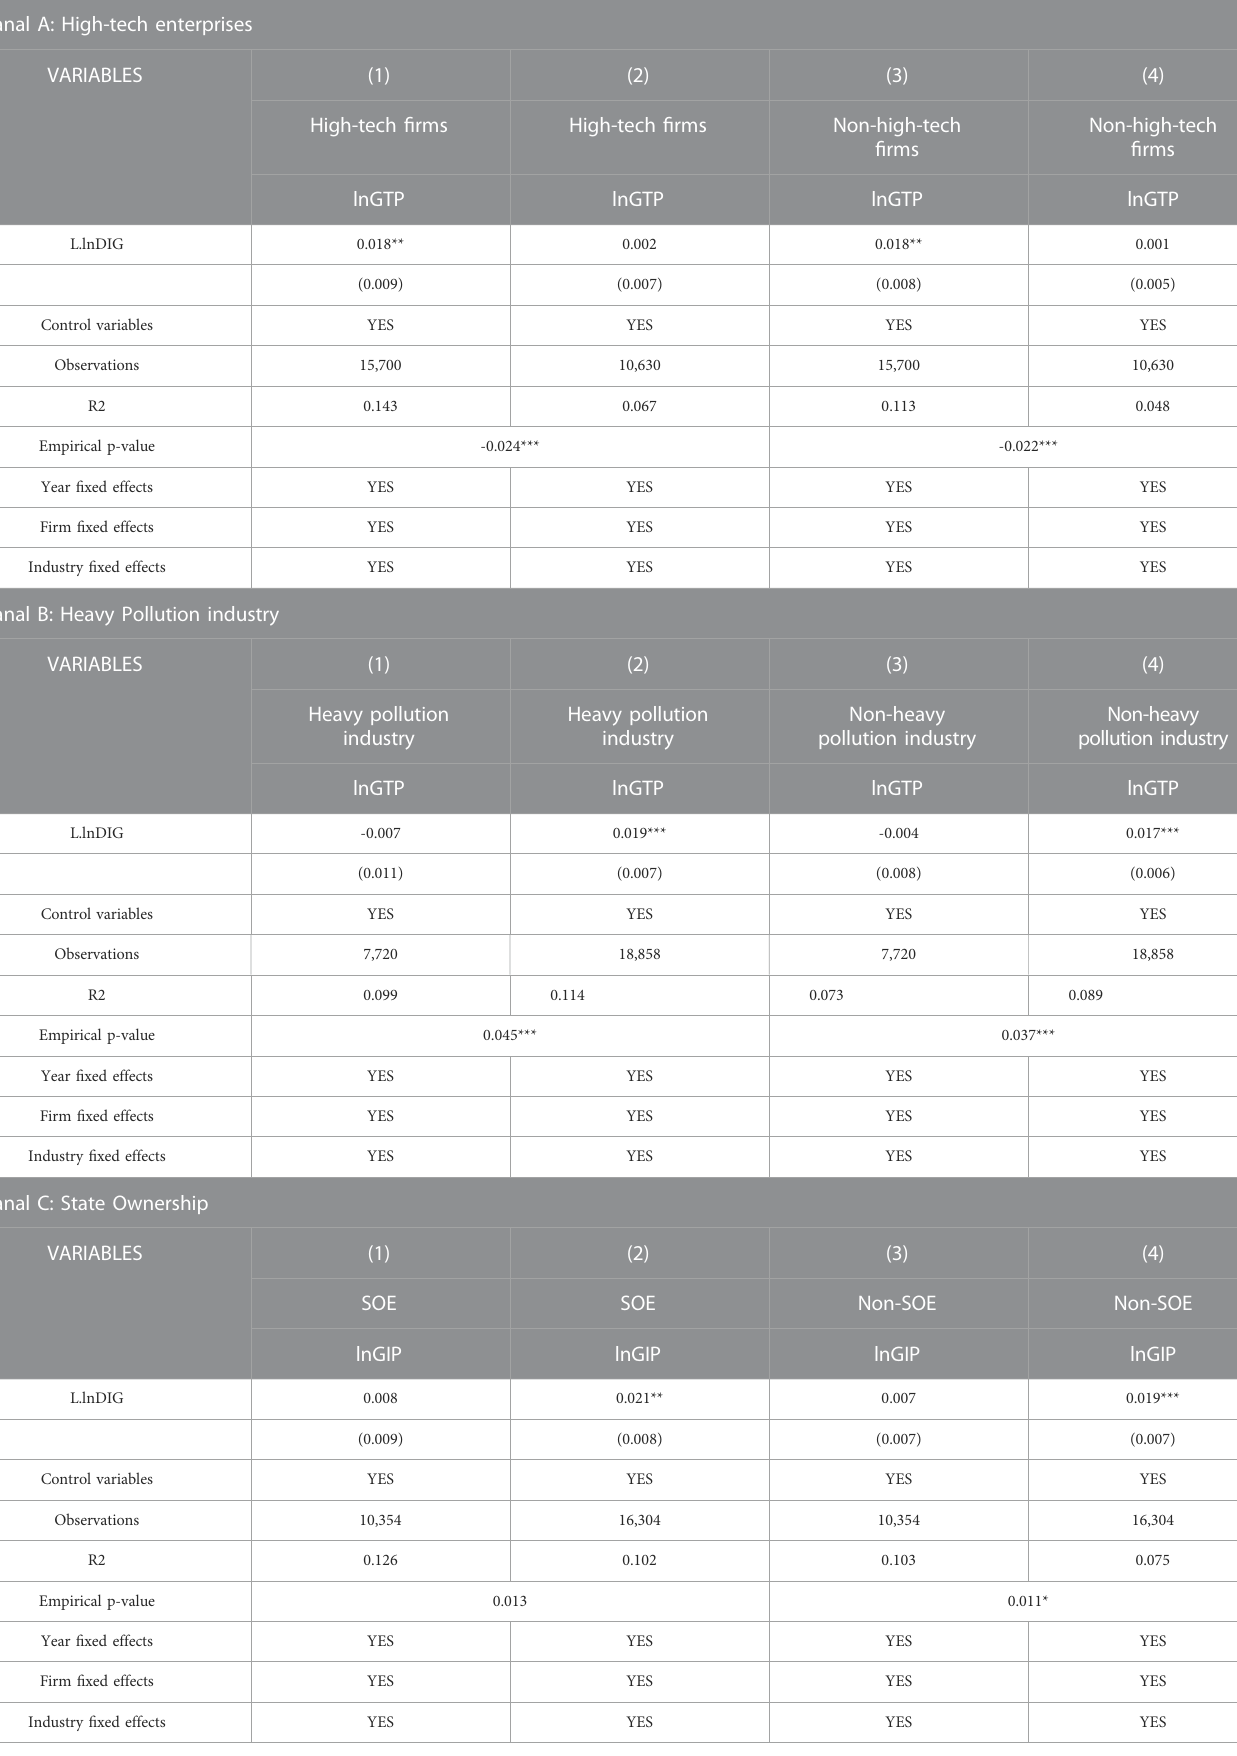
TABLE 10 Heterogeneous effect analysis. Panal A: High-tech